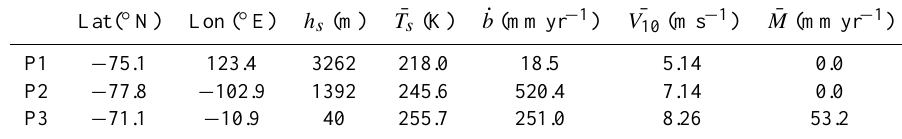
Table 2: RACMO2/ANT climate characteristics of points P1, P2 and P3: latitude, longitude, height above sea level, average annual temperature, accumulation, 10 m wind speed and melt over the 1979–2009 period.